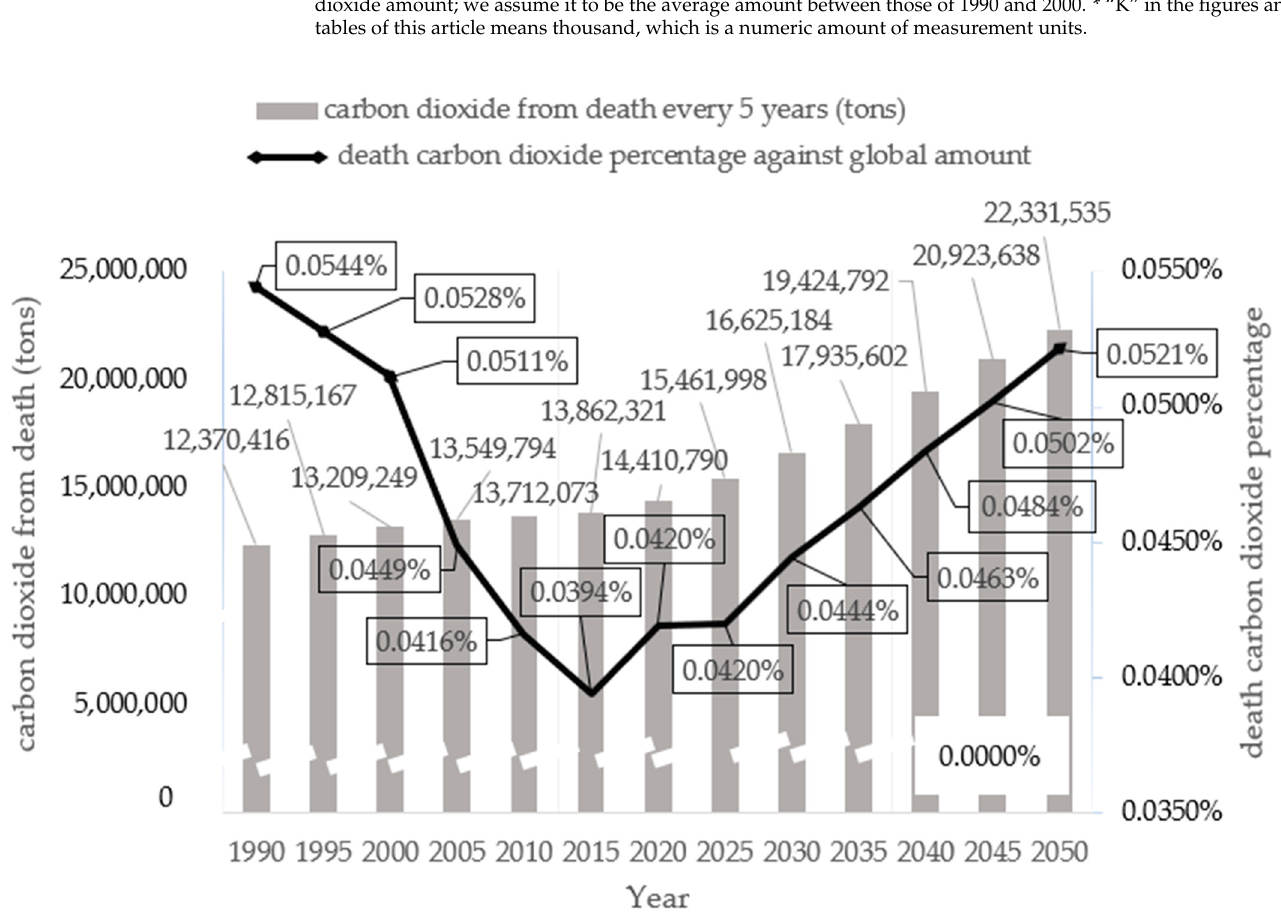
Table 4. The simulation of carbon dioxide generated from the death toll from 10% to 30% every 5 years between 2030 and 2050.